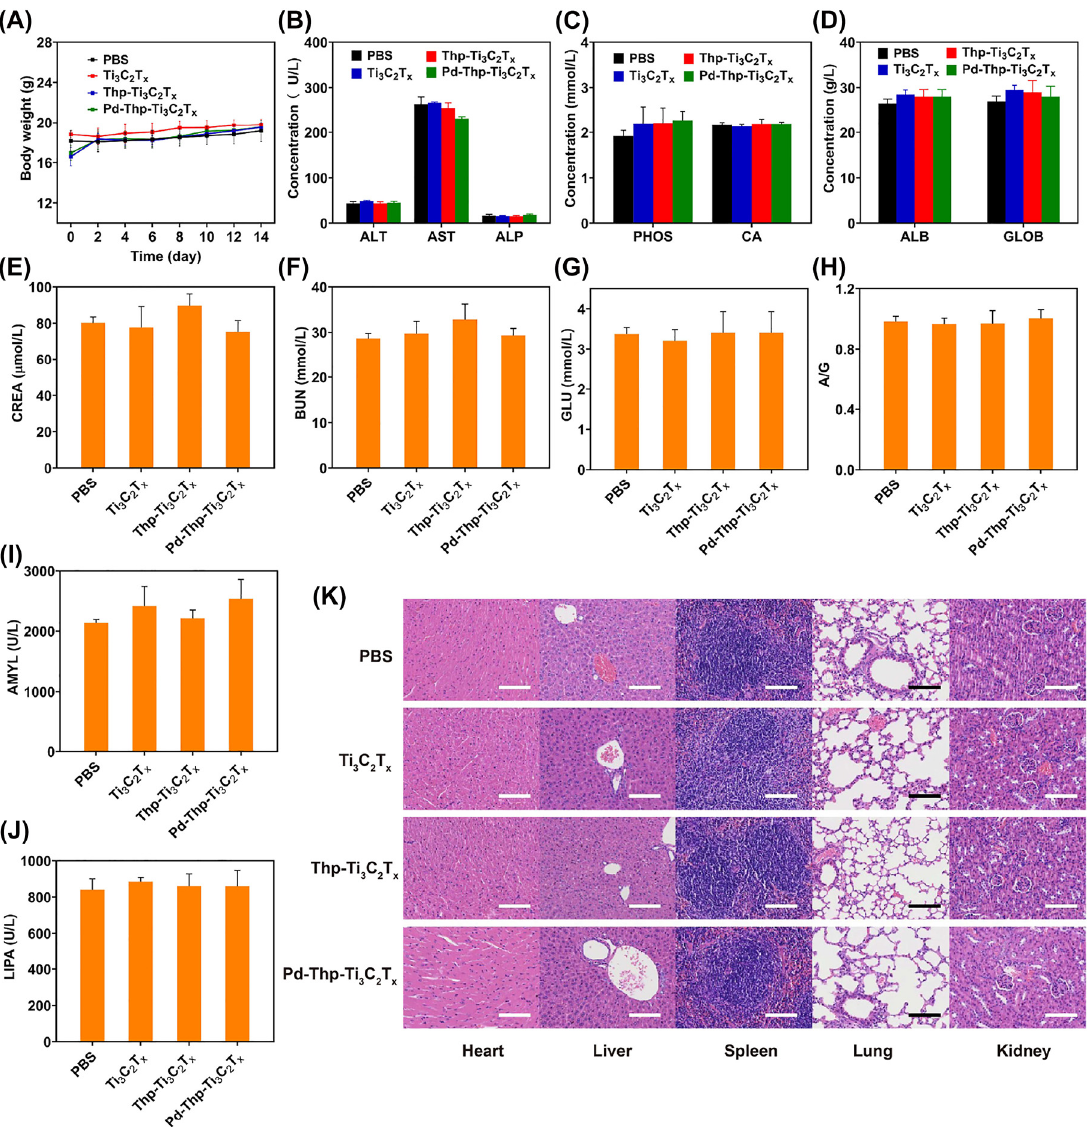
Figure 6: In vivo biosafety evaluation of various nanocomposites. (A) Time-related body weight of BALB/c mice after the intravenous administration with different nanocomposites. (B–J) Blood biochemical analysis of BALB/c mice after the intravenous administration with different composites at 14th day. (K) H&E-stained tissue sections of major organs from BALB/c mice in biosafety experiments (Scale bar: 100 μ